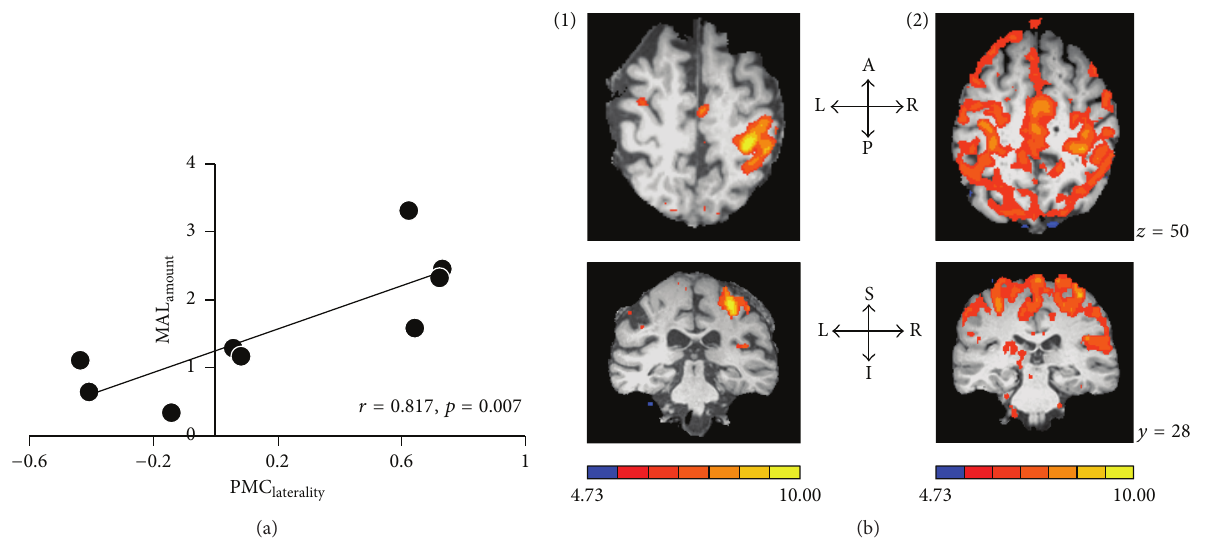
Figure 1: Role of ipsilesional premotor areas: from our work in Cunningham et al. [38]. PMC: premotor cortex (synonymous with PMd here); MAL: motor activity log. The figure explains the potential of ipsilesional higher motor areas including ipsilesional PMd in recovery. Patients with wide-ranging baseline impairments undergo functional MRI during movement of the paretic hand. Activation of ipsilesional versus contralesional cortices is computed using a laterality index, where a higher positive value suggests cortices contralateral to the paretic limb are activated. (a) demonstrates that patients who show better laterality for PMd, that is, greater activation of ipsilesional versus contralesional PMd ( 𝑥 -axis), perceive less disability in using their paretic hand ( 𝑦 -axis). Perception of disability is signified using a popular scale, known as MAL. Values on MAL range anywhere from 0 to 5, where 5 signifies no disability in the use of the paretic hand. (b) presents an illustration of subjective examples. Two patients, labeled 1 and 2, underwent fMRI during movement of their paretic hand. Images show fMRI activation in transverse (top) and coronal (bottom) planes. For simplicity, the lesioned hemisphere is shown to the right of each image. Patient 1 demonstrates focused activation of ipsilesional PMd that coincides with greater laterality, while patient 2 shows weaker laterality because activation of most regions is bilateral. MAL scores for patients 1 and 2, respectively, are 2.3 and 0.66. Therefore, patient 1 who perceived lesser disability in using the paretic hand showed greater activation of ipsilesional PMd, though patient 2 with extreme perception of disability activated multiple other regions. Patients who recover, albeit incompletely, can rely on plasticity of their ipsilesional premotor